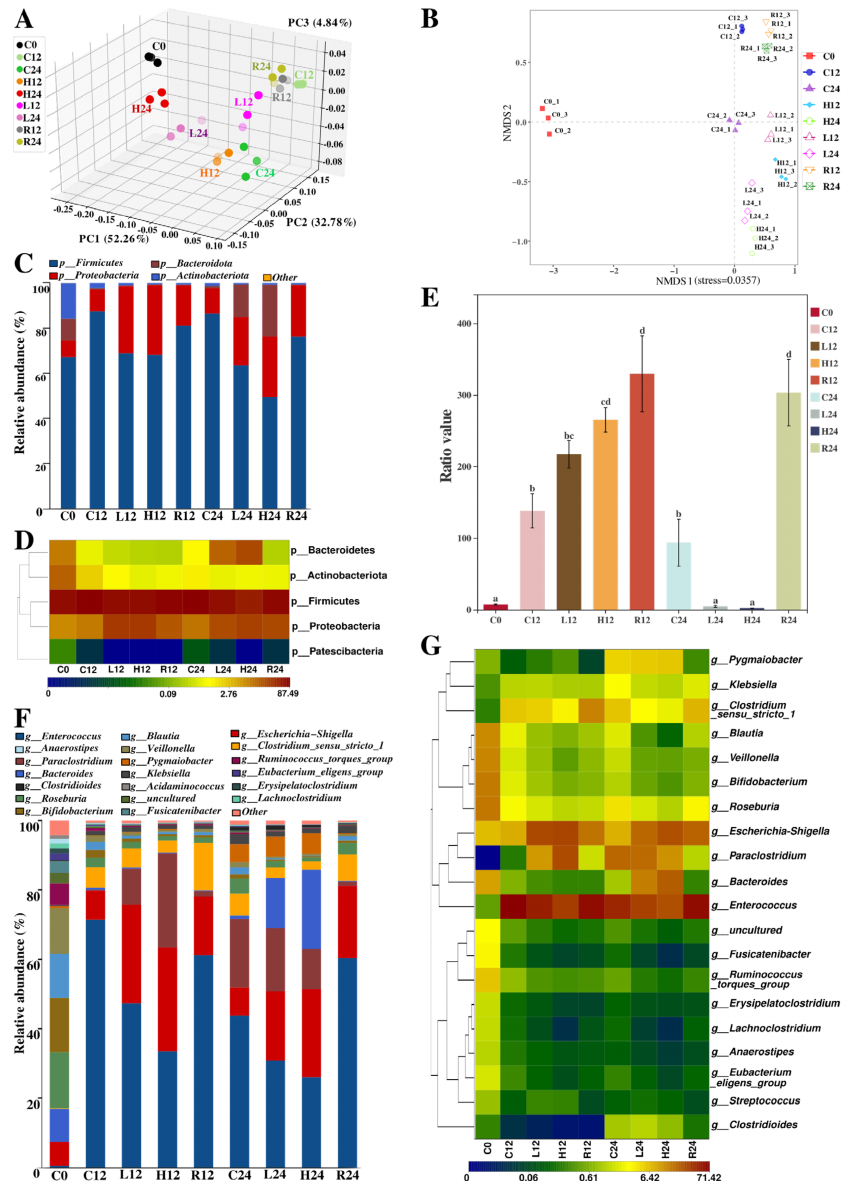
Figure 5. Beta diversity analysis and taxonomic analysis of fecal microbiota: ( A ) The principal coordi- nates analysis (PCoA) is based on weighted Unifrac distance. ( B ) The nonmetric multidimensional scaling (NMDS). ( C ) Microbial taxa composition at the phylum level. ( D ) Hierarchical cluster analysis of main OTUs at the phylum level. ( E ) The ratios of Firmicutes/Bacteroidetes. Different lower- case superscript letters indicate significant differences ( p < 0.05) in different samples. ( F ) Microbial taxa composition at the genus level. ( G ) Hierarchical cluster analysis of main OTUs at the genus level. PC, Principal component; C, blank group; L, low-dose group; H, high-dose group; R, positive control